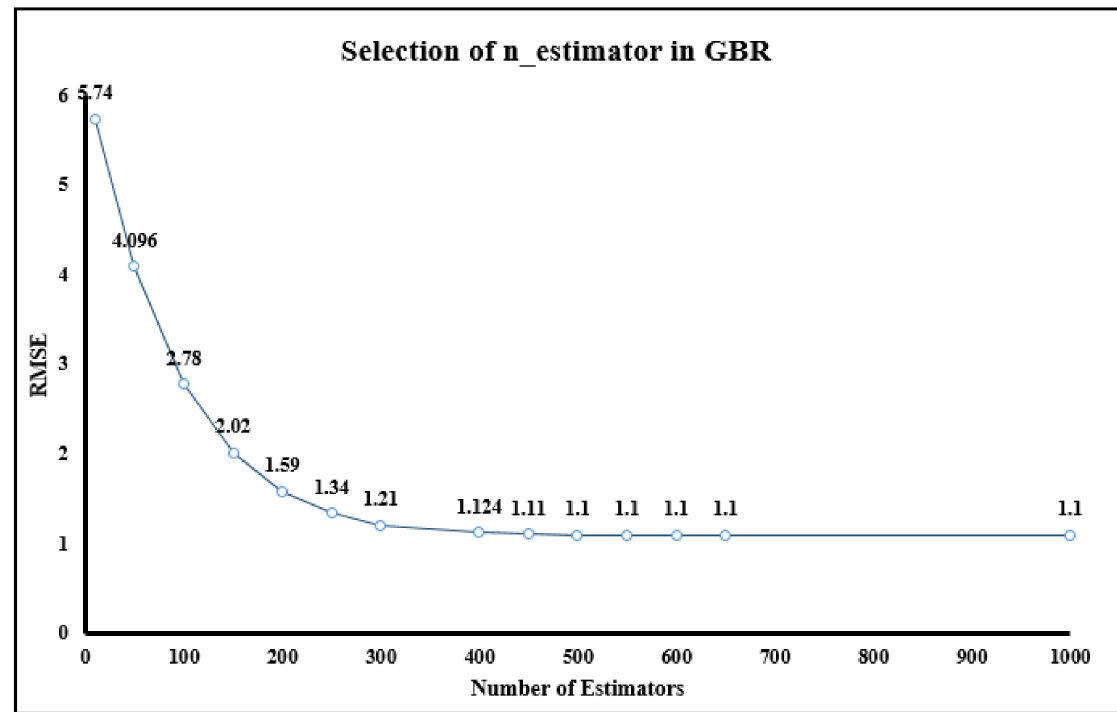
Figure 5. RMSE of GBR with different numbers of